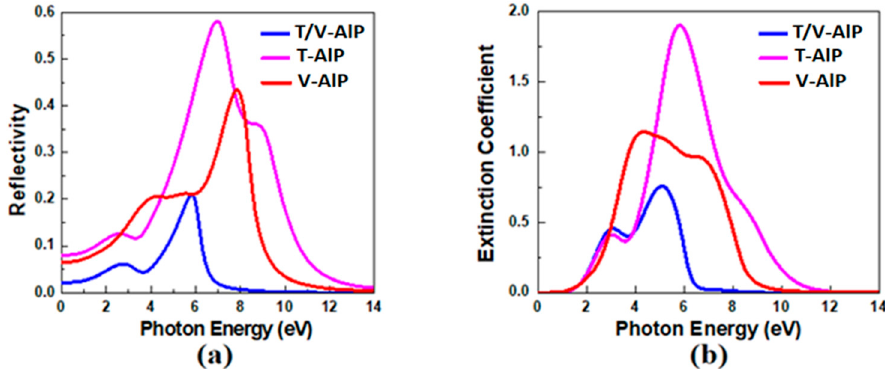
Figure 10. ( a ) The reflectivity and ( b ) the extinction coefficient of the three types of AlP bilayers.